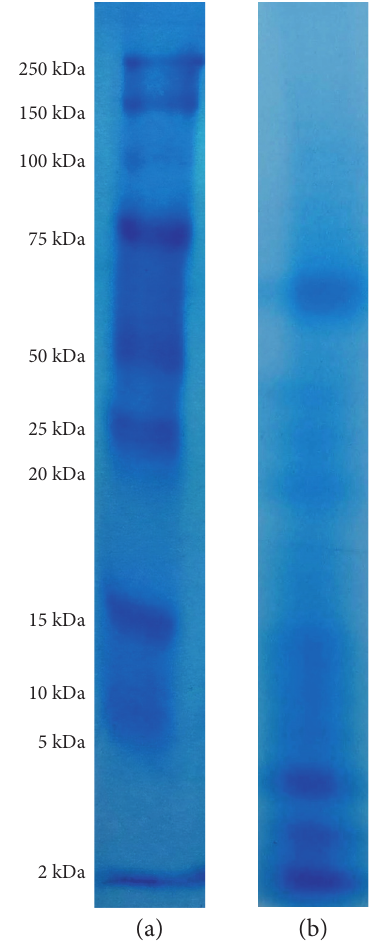
Figure 2: SDS-PAGE profile of (a) molecular weight marker and (b) optimized liquid